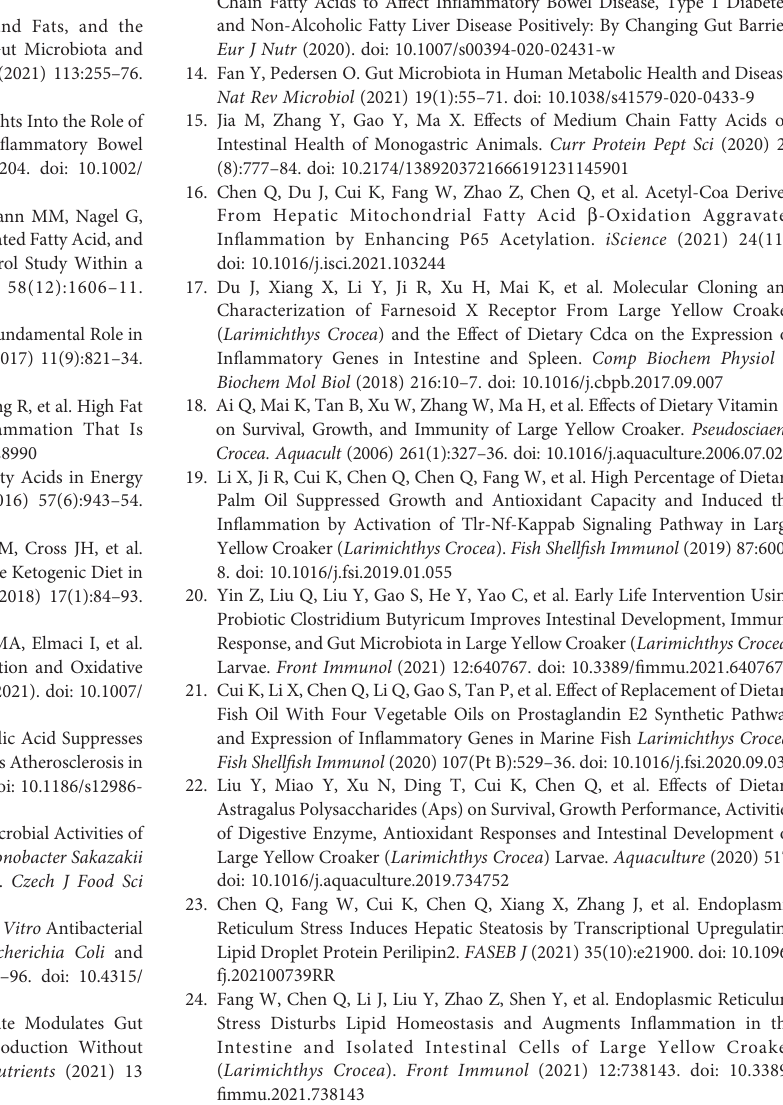
Supplementary Table 5 | The list of abbreviations. Supplementary Figure 1 | The protocol of the experiment. Intestinal damage of large yellow croaker was induced by 70 g/kg SO in the diet for 10 weeks feeding experiment. Different concentrations of sodium OCT were intervened, and collected the samples after feeding experiment. Supplementary Figure 2 | The per-experiments of exploring the appropriate concentration of DHA and LA to simulate the situation in vivo (A, B) . The relative mRNA expression of key antioxidation-related genes ( cat , nrf2 , sod1 , and sod2 ) (A) and the fold change of ROS in intestinal cells (B) . The evaluation of sequencing efforts ’ completeness and depth (C – F) . Both the rarefaction curve (C) and species accumulation boxplot (D) of mucosal microbiota, tended to approach the saturation plateau. The rarefaction curve (E) and species